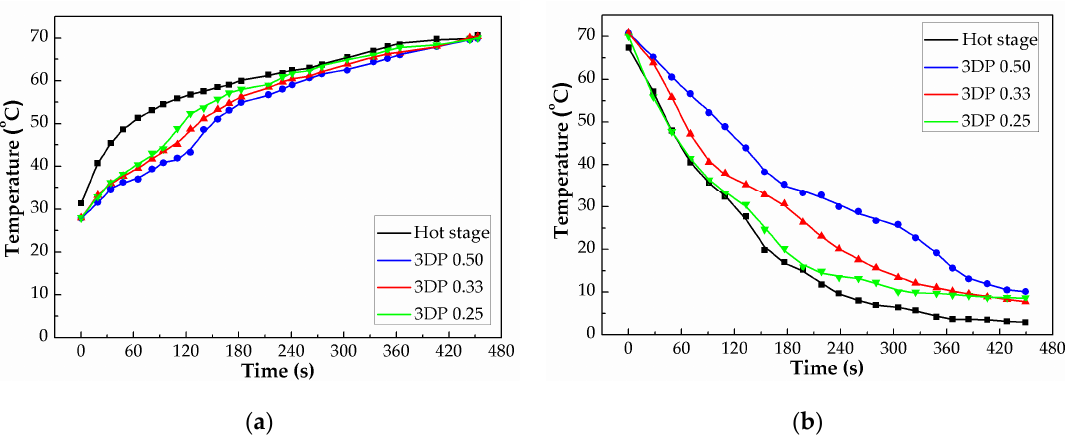
Figure 11. Temperature change as a function of time detected by an infrared thermal graphic camera for 3D printed crystalline P(SA-DMAA) gels in one heating ( a ) and cooling ( b ) cycle. A buffer zone and the temperature differences between 3DP gel samples and hot stage were clearly observed.